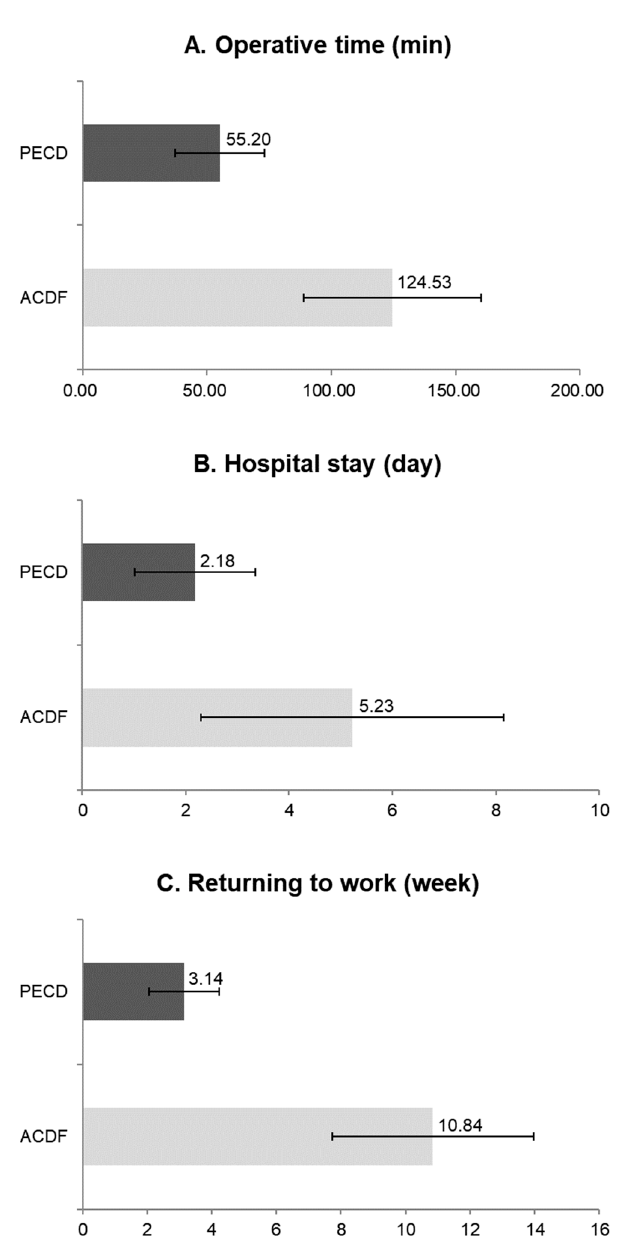
Figure 5. Perioperative data. A . Operative time was significantly shorter in the percutaneous endoscopic cervical discectomy (PECD) group than in the anterior cervical discectomy and fusion (ACDF) group (55.20 ± 18.03 min vs. 124.53 ± 35.68 min; p < 0.01). B . The hospital stay was significantly shorter in the PECD group than in the ACDF group (2.18 ± 1.16 d vs. 5.23 ± 2.93 d; p < 0.01). C . The time to return to work was significantly shorter in the PECD group than in the ACDF group (3.14 ± 1.08 weeks vs. 10.84 ± 3.12 weeks; p < 0.01).